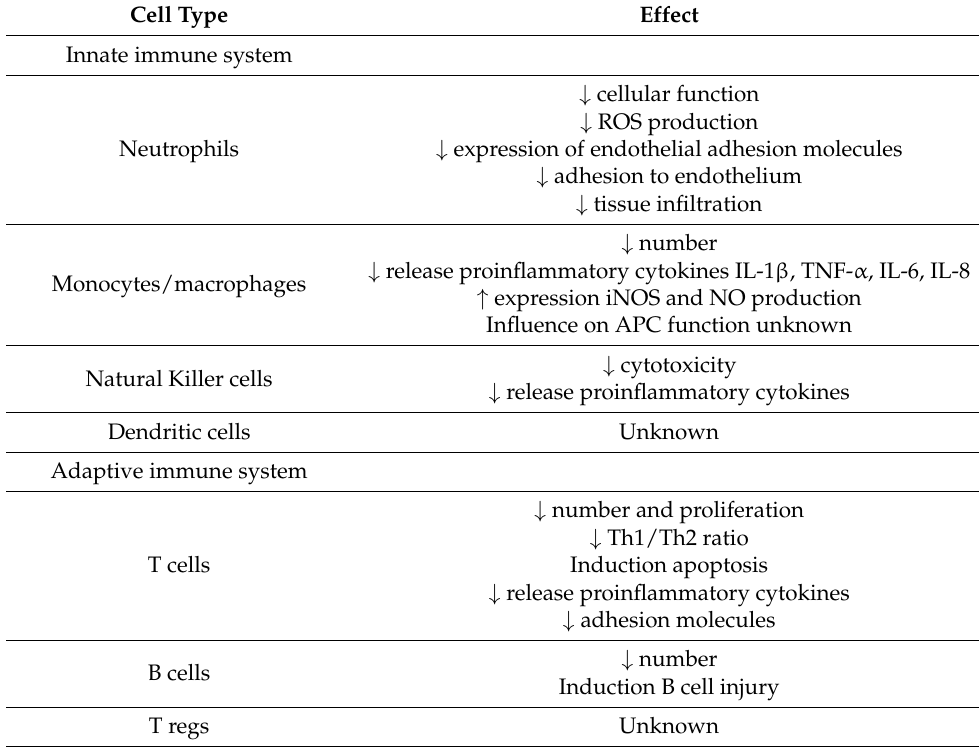
Table 1. Effects of volatile anesthetics on various cells of the immune